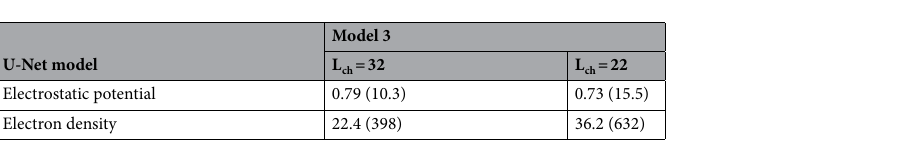
Table 2. Mean and maximal (in brackets) percentage errors (%) of extrapolation cases (L ch = 32 and 22 nm) of U-Net models trained by data with L ch = 30, 28, 26 and 14 nm (Model 3) at VGS = 0.29